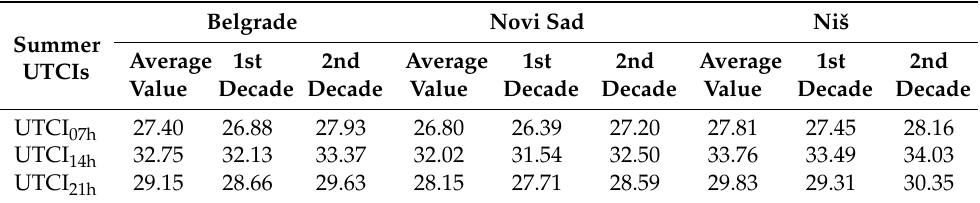
Table 4. Average summer UTCIs values in Belgrade, Novi Sad, and Niš for the period 1999–2018, and average decade-long UTCIs values for the 1st decade (1999–2008) and 2nd decade (2009–2018).